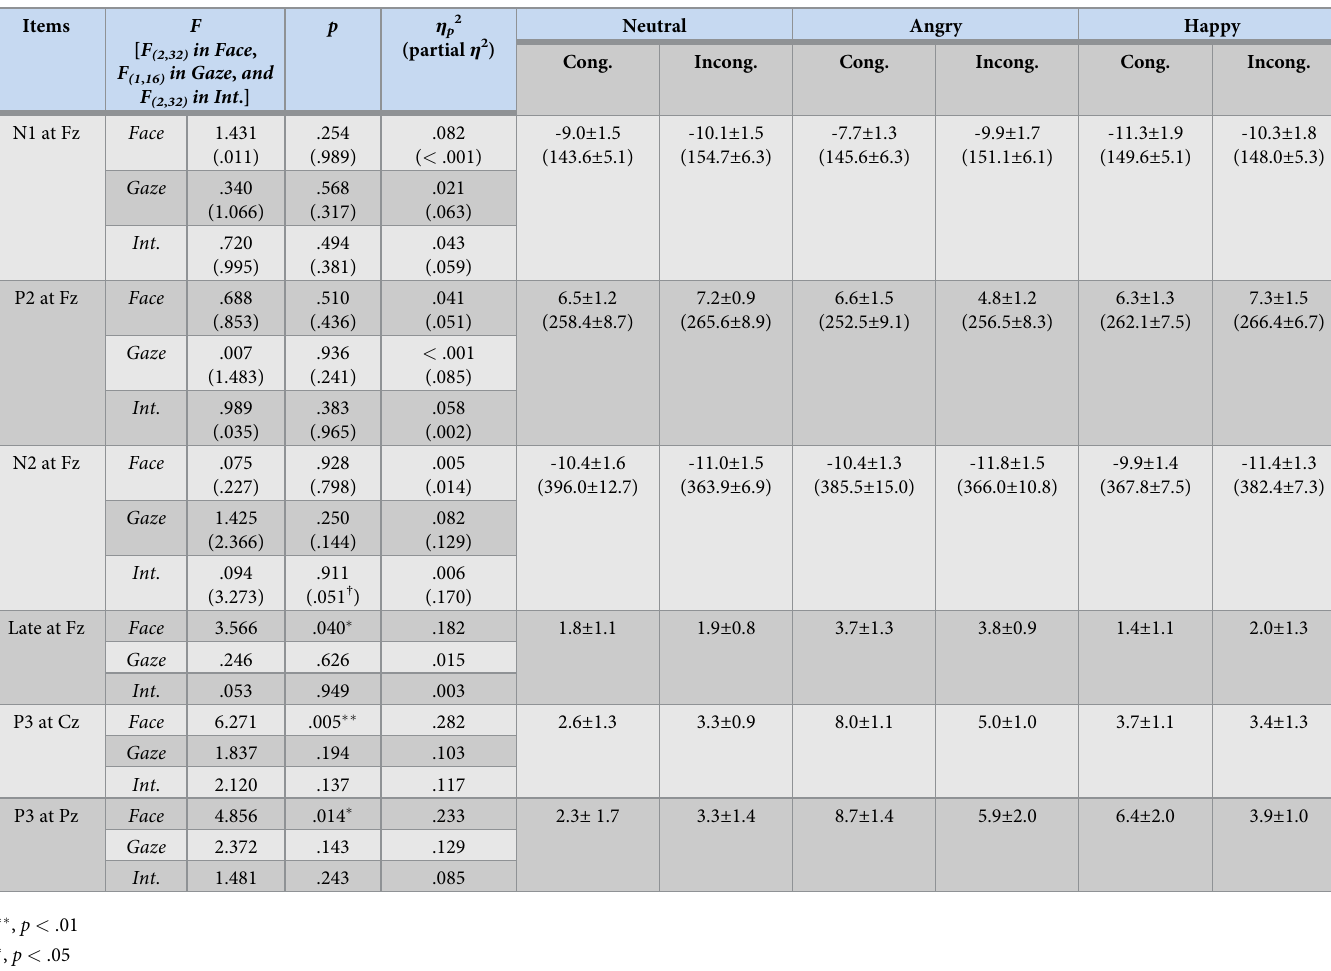
Table 2. ERPs ( μ V) during the working memory task for preschool children. Items F [ F , (2 , 32) in Face F (1 , 16) in Gaze , and F (2 , 32) in Int